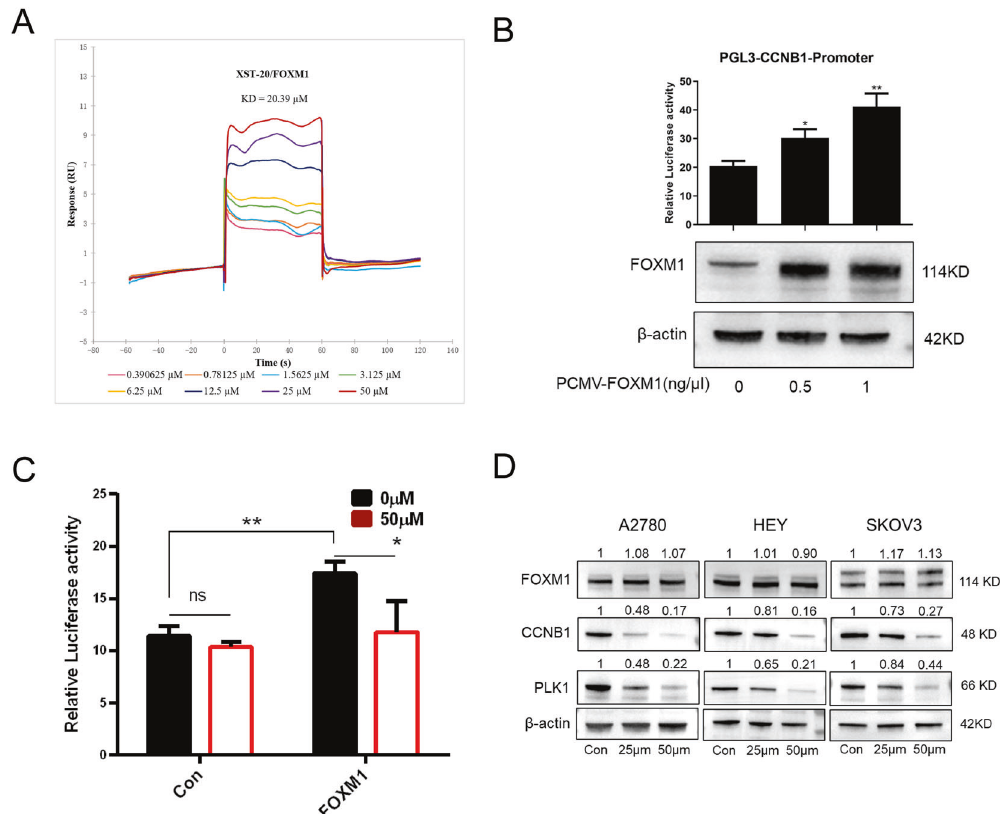
Fig. 4 XST-20 speci fi cally blocks FOXM1 DNA-binding and inhibits its transcriptional activity. A Interaction between XST-20 and FOXM1 (222 – 360) peptide was detected by surface plasmon resonance (SPR) assay. B Luciferase activity of CCNB1 promoter was evaluated in cells with FOXM1 overexpression. C Luciferase activity of CCNB1 promoter was evaluated in cells with FOXM1 overexpression and control group treated with XST-20. D Expression levels of FOXM1 and downstream targets were Measured by western blot in three ovarian cancer cell lines (A2780, HEY, and SKOV3) treated with XST-20. Data were presented as means ± S.D. * p < 0.05, ** p <